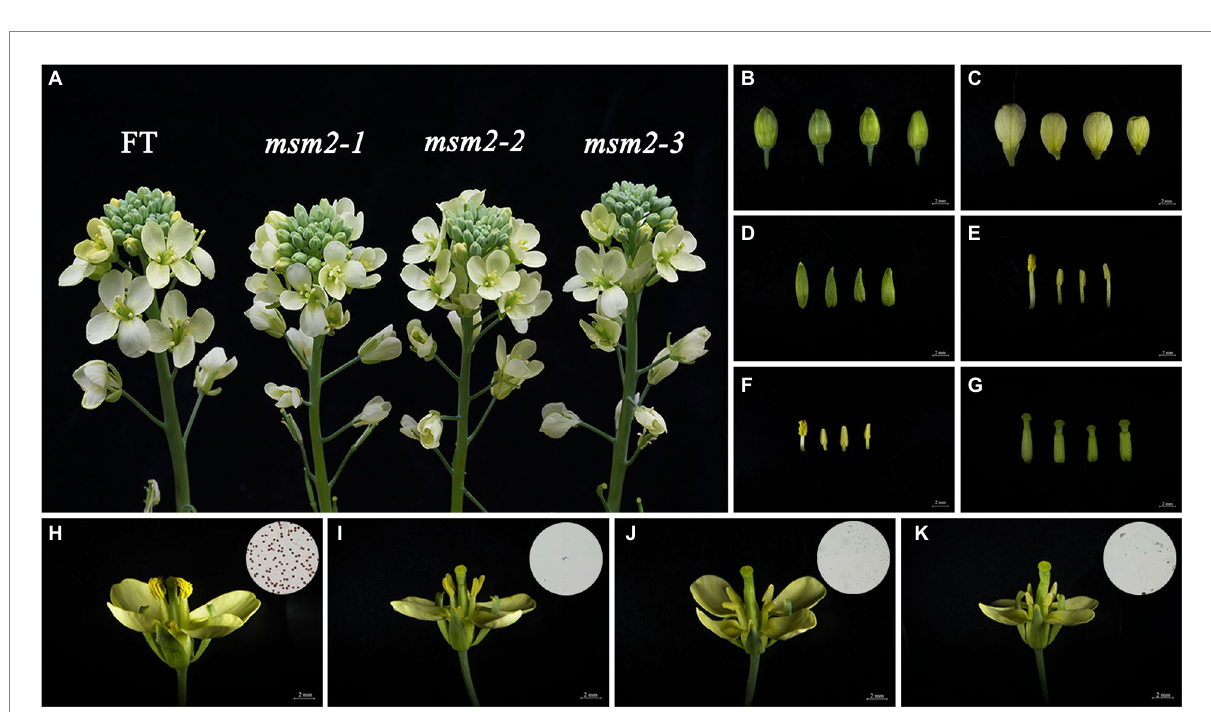
FIGURE 1 Phenotypic analysis of the wild-type “FT” and msm2-1/2/3 mutants. Comparison of the floral organs of the wild-type “FT” and mutant msm2- 1/2/3 (from left to right). (A) Inflorescence (B) buds, (C) petals, (D) sepals, (E) stamens (long), (F) stamens (short), (J) pistils. Scale bar 2 mm analysis of pollen viability of the wild-type “FT” (H) , msm2-1 (I) , msm2-2 (J) , and msm2-3 (K) . Scale bar 150 μ